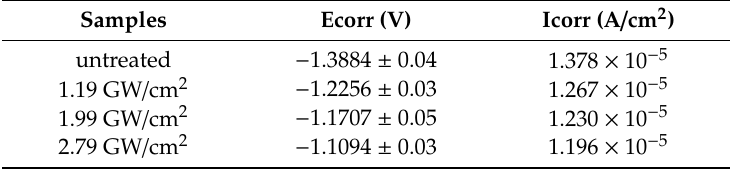
Table 4. The electrochemical parameters of potentiodynamic polarization